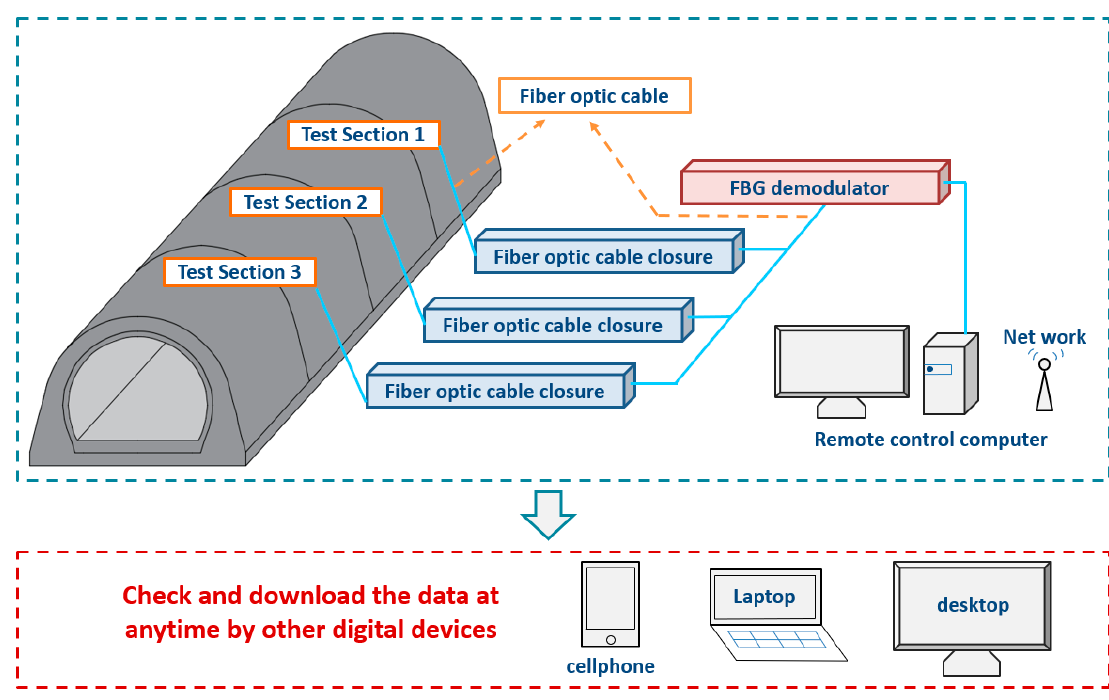
Figure 9. Automatic data collecting and delivering system.